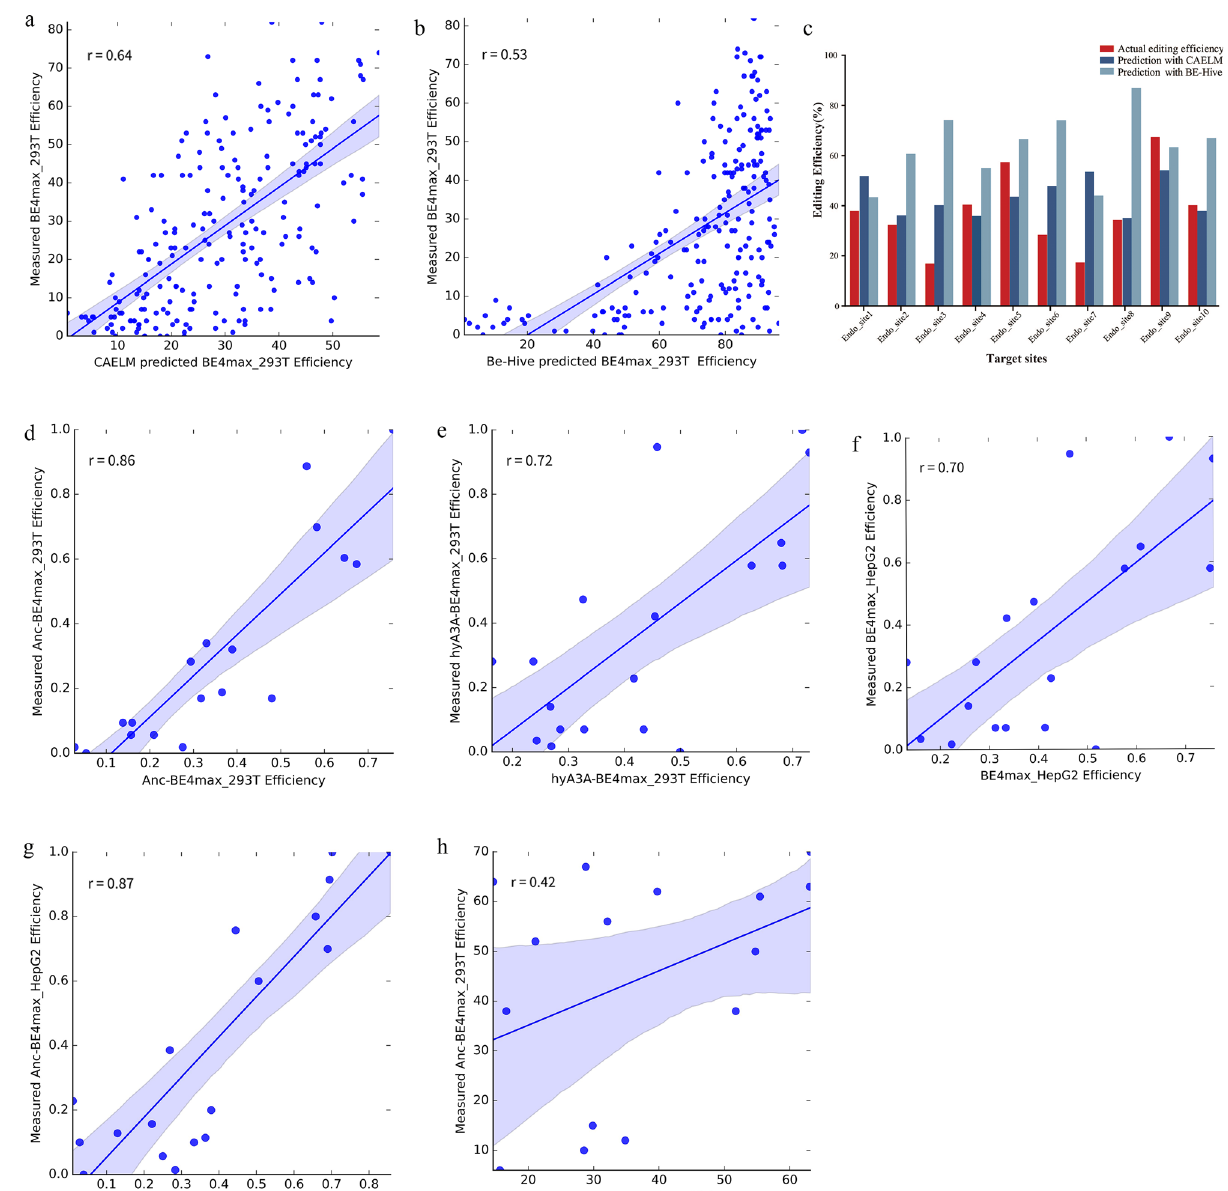
Fig. 5 | The performance of the Chromatin Accessibility Enabled Learning Model(CAELM) for prediction base editing outcome. Linearregression plots of fi g. 5a, b, d – h. are presented with a 95% con fi dence-interval band around the regression line a Correlation between the editing ef fi ciency predicted by XGB Regressor versus the actual values for BE4max.The Pearson ’ s correlation coef fi - cient (r) is shown. b Comparison of BE-Hive predicted (x-axis) and actual base editingef fi ciencies(y-axis).ThePearson ’ scorrelationcoef fi cient(r)isshown. c The performance comparison of the CAELM and BE-Hive. d Correlation between the editing ef fi ciency predicted by XGB Regressor versus the actual values for Anc-